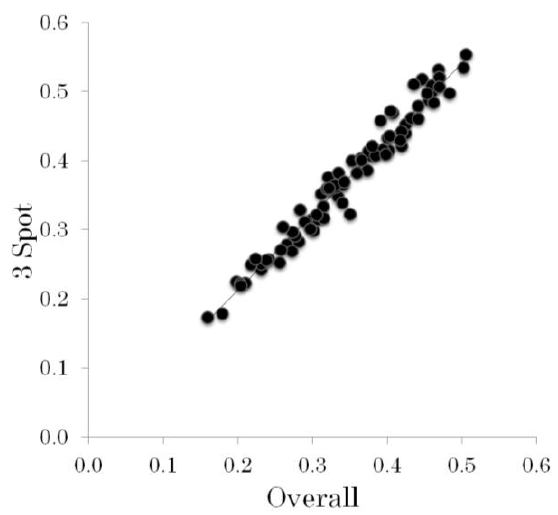
Figure 3. Relationship between measurements by overall trace and 3 spot methods for longissimus